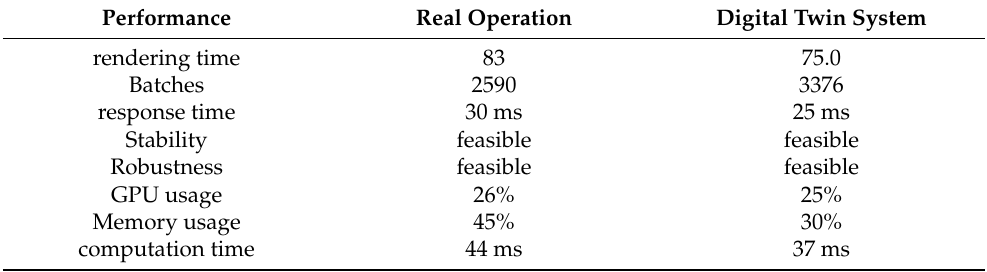
Table 2. System evaluation performance